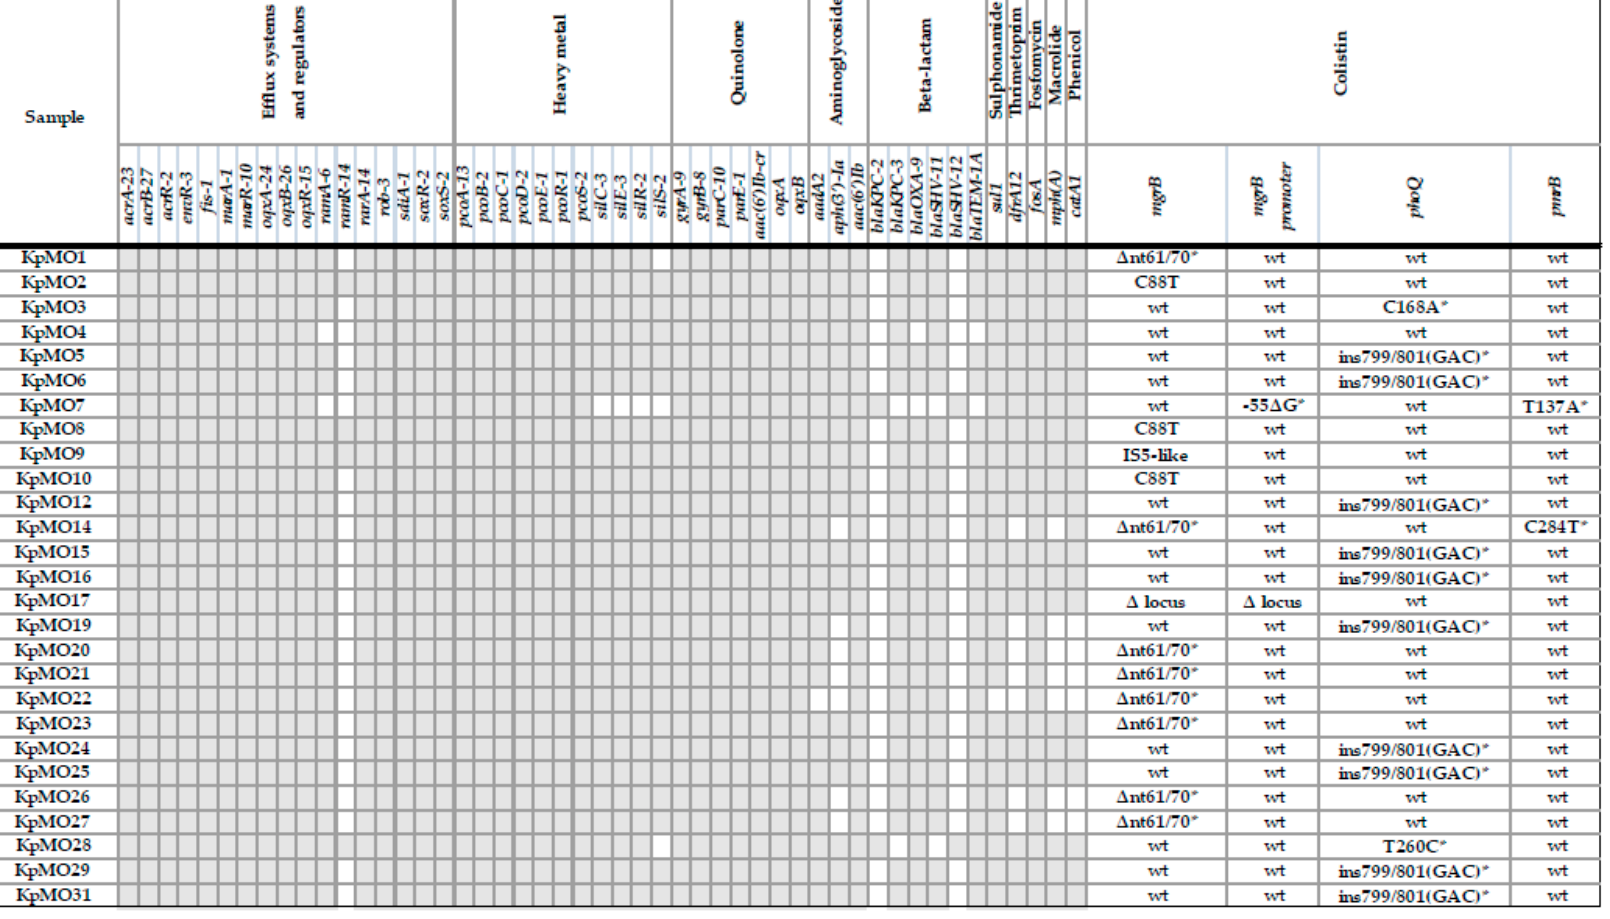
Figure 1. Resistome data. Resistome data obtained by ResFinder-2.1 software, Pasteur MLST Kp database and running BLAST are here summarized. In particular, in the left box, grey and white colors represent gene presence and absence respectively; in the right box the colistin-resistance related mutations are grouped. The revealed genes are grouped with respect to the related resistance mechanism. Concernig colistin resistance, many different mechanisms have been reported. Prior to 2015, colistin resistance had only been linked to mutational and regulatory changes mediated by chromosomal genes controlling lipopolysaccharide (LPS) modifications. In Kp , the LPS modification is mediated by the activation of different two-component regulatory systems (TCRSs): PmrA/PmrB, PhoP/PhoQ, and